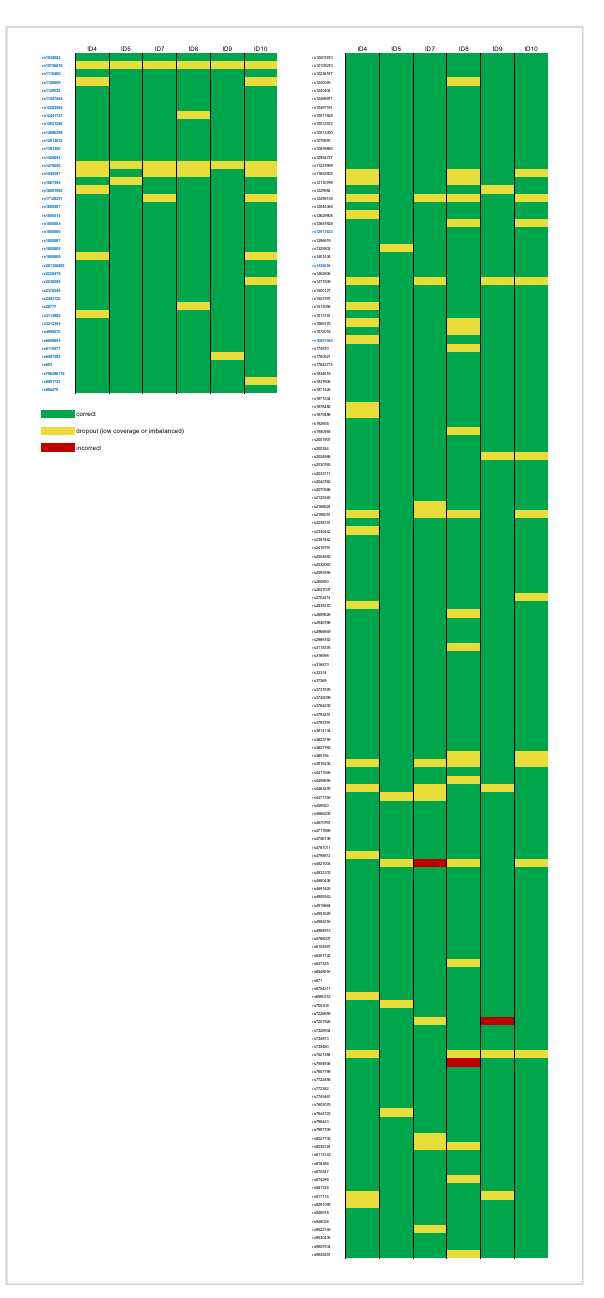
Figure 7. Genotyping summary for the selected single cells (with calling rate of at least 90%); left–41 SNPs used for the phenotype prediction, right–145 SNPs used for ancestry prediction.